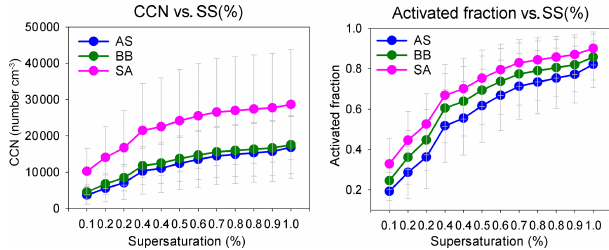
Figure 5. Variation in CCN and activated fraction with SS (%) for AS, BB, and SA air